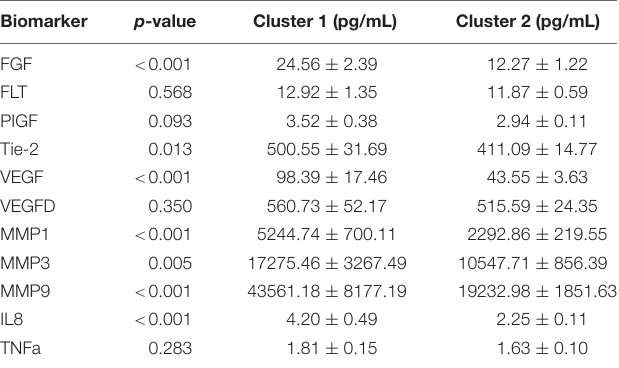
TABLE 2 | Means ± SEM for clusters 1 and 2 produced by the combined HCA model.